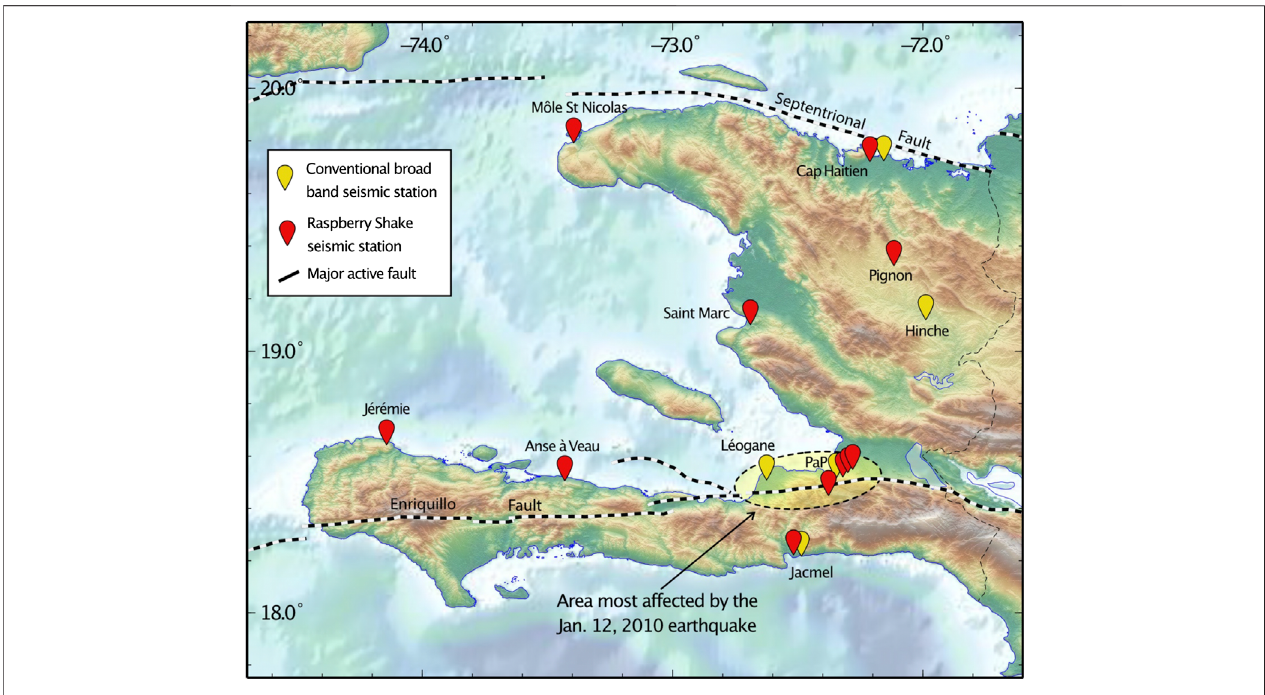
FIGURE 1 | Map of Haiti showing the main active faults (dashed lines), the area most affected by the M7.1, January 12, 2010, earthquake, the location of conventional broadband seismic stations, and the location of Raspberry Shake seismic stations installed to date in the framework of the project described here.